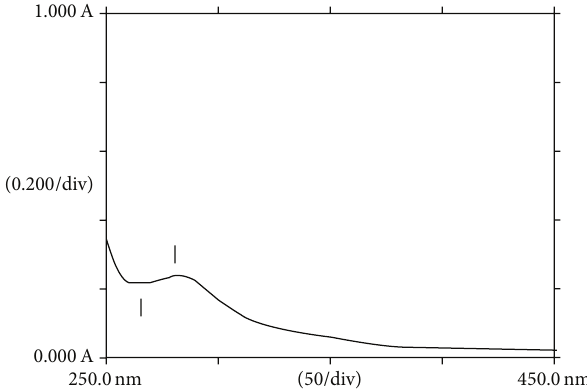
Figure 2: UV spectrum of colistin solution (280nm, 1600IU/mL).